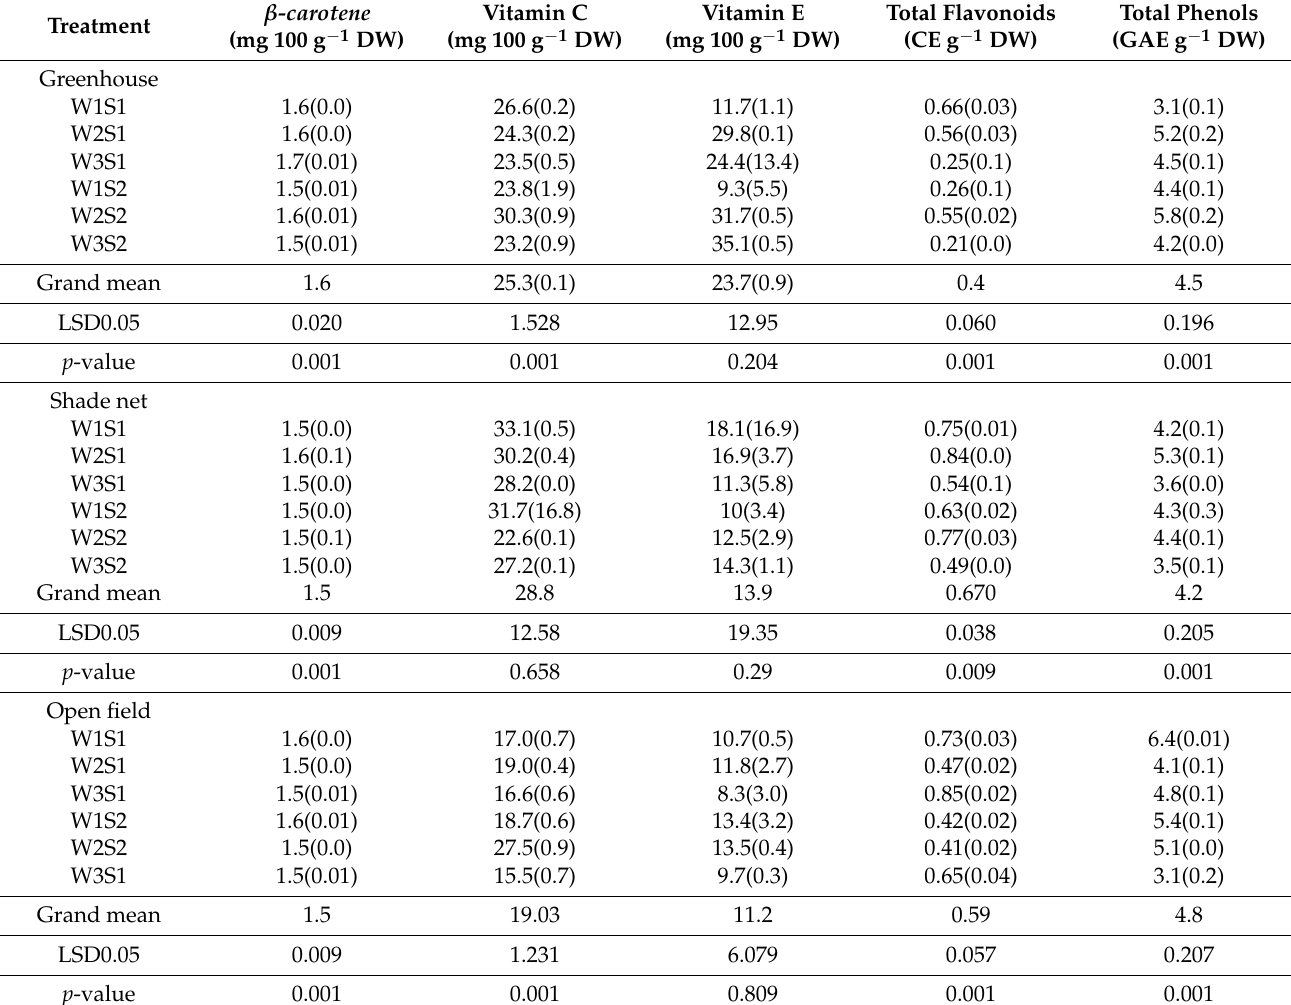
Table 2. Treatment effect on biochemical constituents of African horned cucumber fruit harvested from different growing